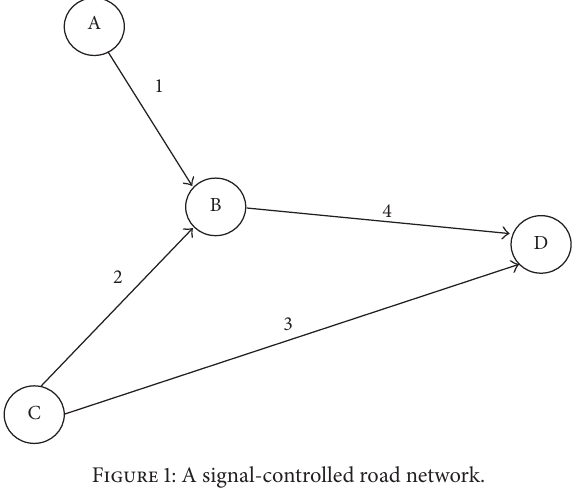
Table 4: Solution of reserve capacity maximization with both signal and